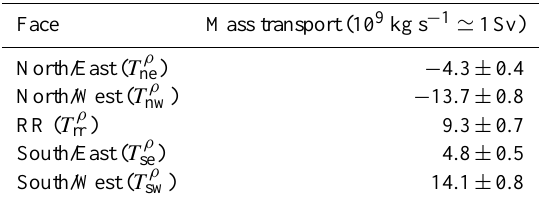
Table 3. Optimized mass transport across each face of the boxes. Transports are positive north or